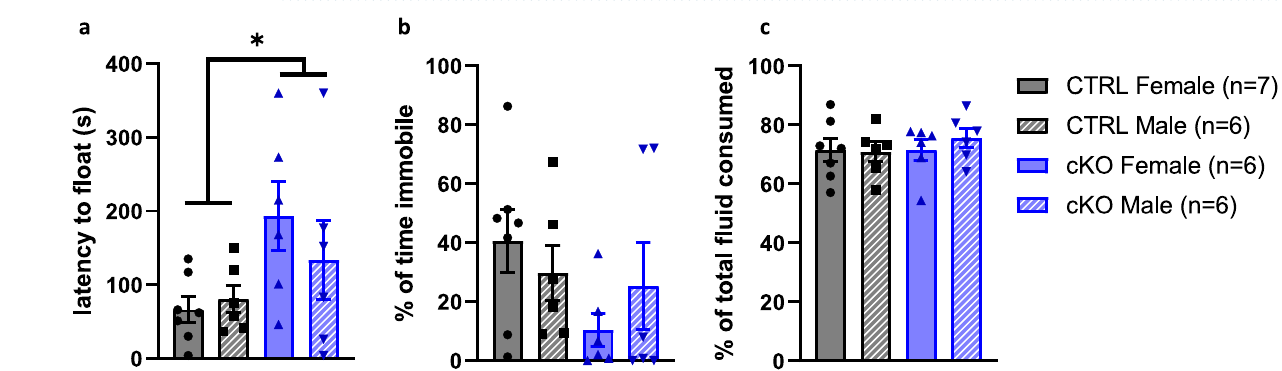
Figure 6. Neuronal Ca V 1.2 cKO mice exhibit longer latency to float but no other antidepressant-like behaviors. ( a ) Neuronal Ca V 1.2 cKO mice exhibit a longer latency to float in the forced swim test compared to CTRL littermates. ( b ) Time immobile in the forced swim test did not differ between groups. ( c ) Neuronal Ca V 1.2 cKO and CTRL mice both prefer sucrose over water. We observed no group differences in sucrose consumption. Data are expressed as mean ±